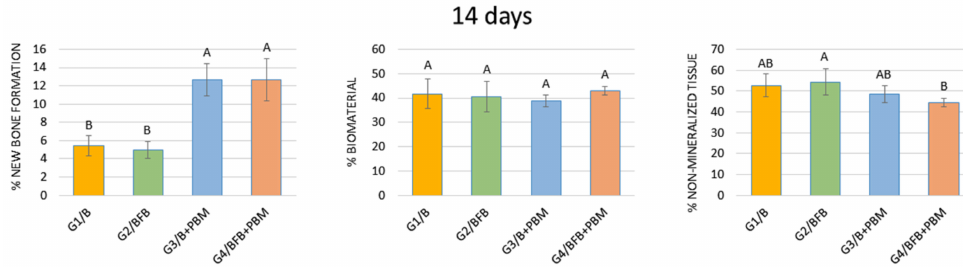
Figure 10. Percentage of new bone formation, biomaterial, and non-mineralized tissue in the experi- mental groups at 14 days. The different letters (A (cid:54) = B) indicate a statistically significant difference ( p <